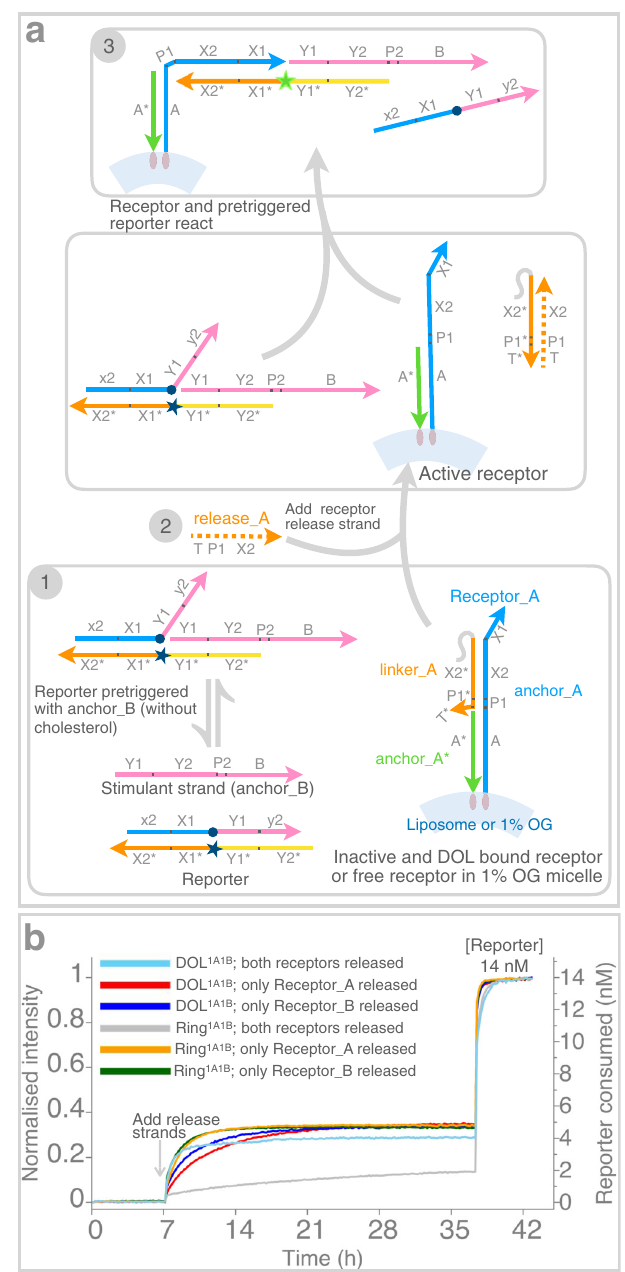
Fig. 3 | Determining tethering ef fi ciency. Tethering ef fi ciencyof receptors to the DOL 1A1B platform was determined by comparing the extent of receptor reaction when one or both the receptors were released and reacted normally within the DOL, and when one or both the receptors reacted with a receptor complex in the presenceofastimulantstrandinsolution. a showsamodi fi edlogiccircuitinwhich only receptor Receptor_A was released; a stimulant strand (anchor_B without a cholesterol modi fi cation) was supplied in excess to make up for any missing Receptor_B. A reciprocal experiment using anchor_A without a cholesterol mod- i fi cation is not shown. b Fluorescence curves (as in Fig. 2) where either both the receptors were released with a normal reporter complex (cyan), only Receptor_A